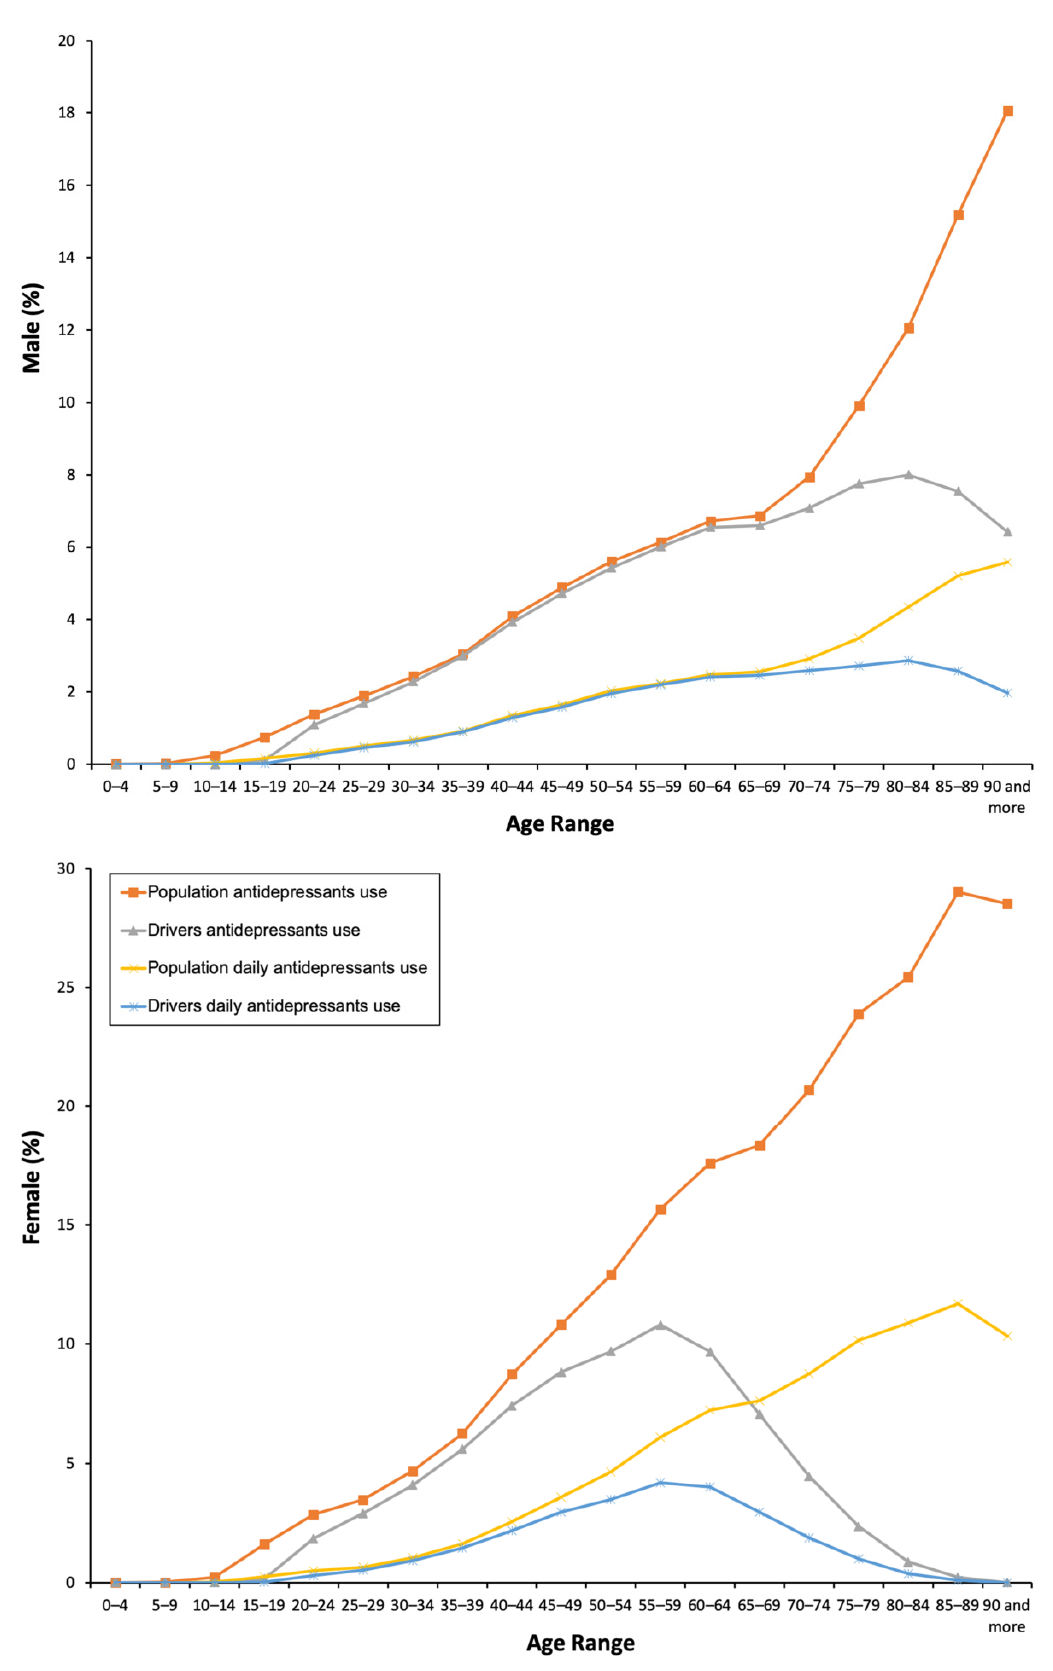
Figure 1. Frequency of antidepressants use by the general population and the driver population.